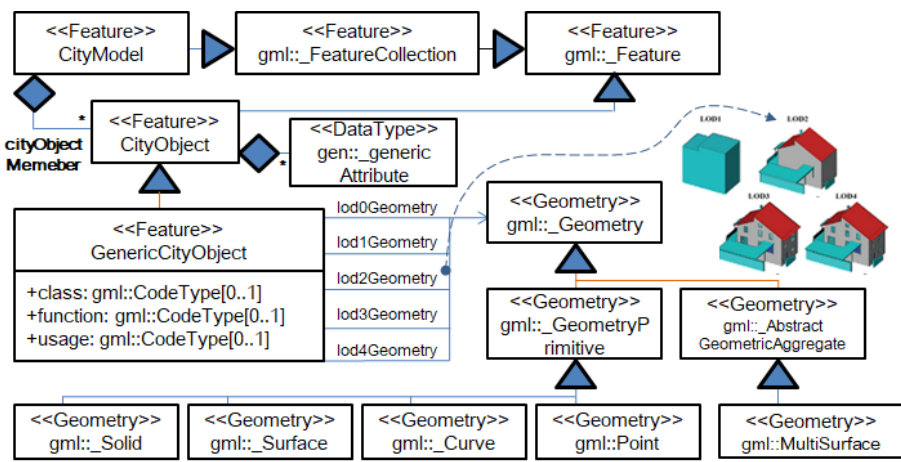
Figure 3. CityGML LOD model.